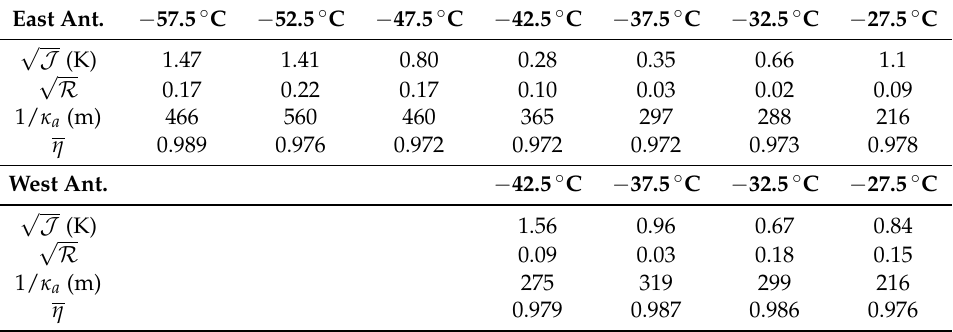
Figure 4. Evolution of: ( a ) the square root of cost function ( c ) mean emissivity η , and ( d ) e-folding depth 1/ κ a (m) along the iteration steps of the retrieval process. Temperature slice: between − 45 and − 40 ◦ C in East Antarctica. Table 1. Square root of components J and R of the Lagrangian function, and corresponding best-fit values of 1/ κ a and η , for each temperature slice ( ◦ C), designed by its mean. For the sake of clarity, results are shown for e-folding depth 1/ κ a , expressed in meters. East